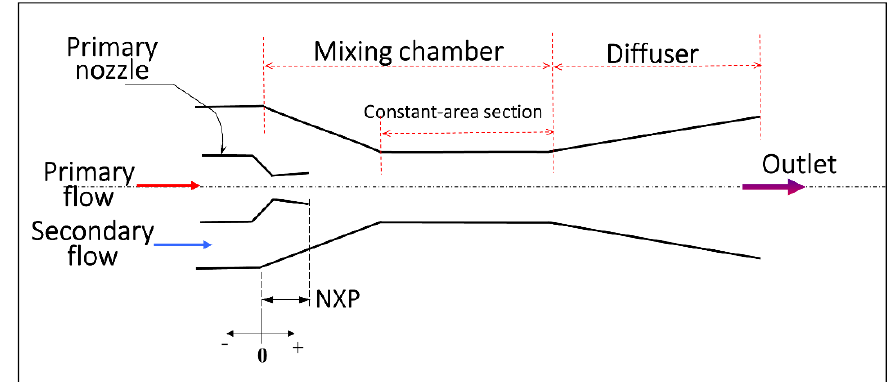
Figure 1. Schematic of an ejector.